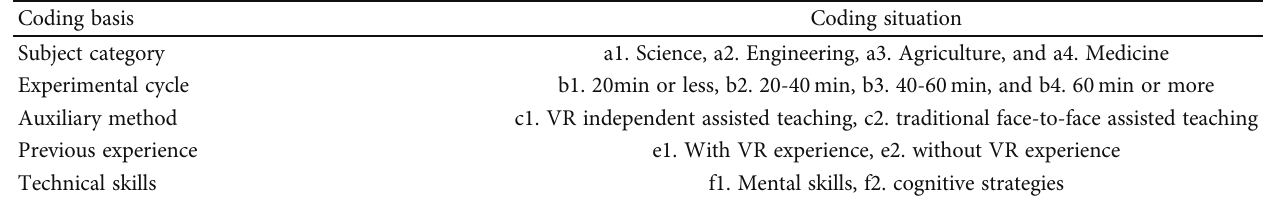
Figure 1: Flow chart of literature screening. Table 1: Literature coding criteria.